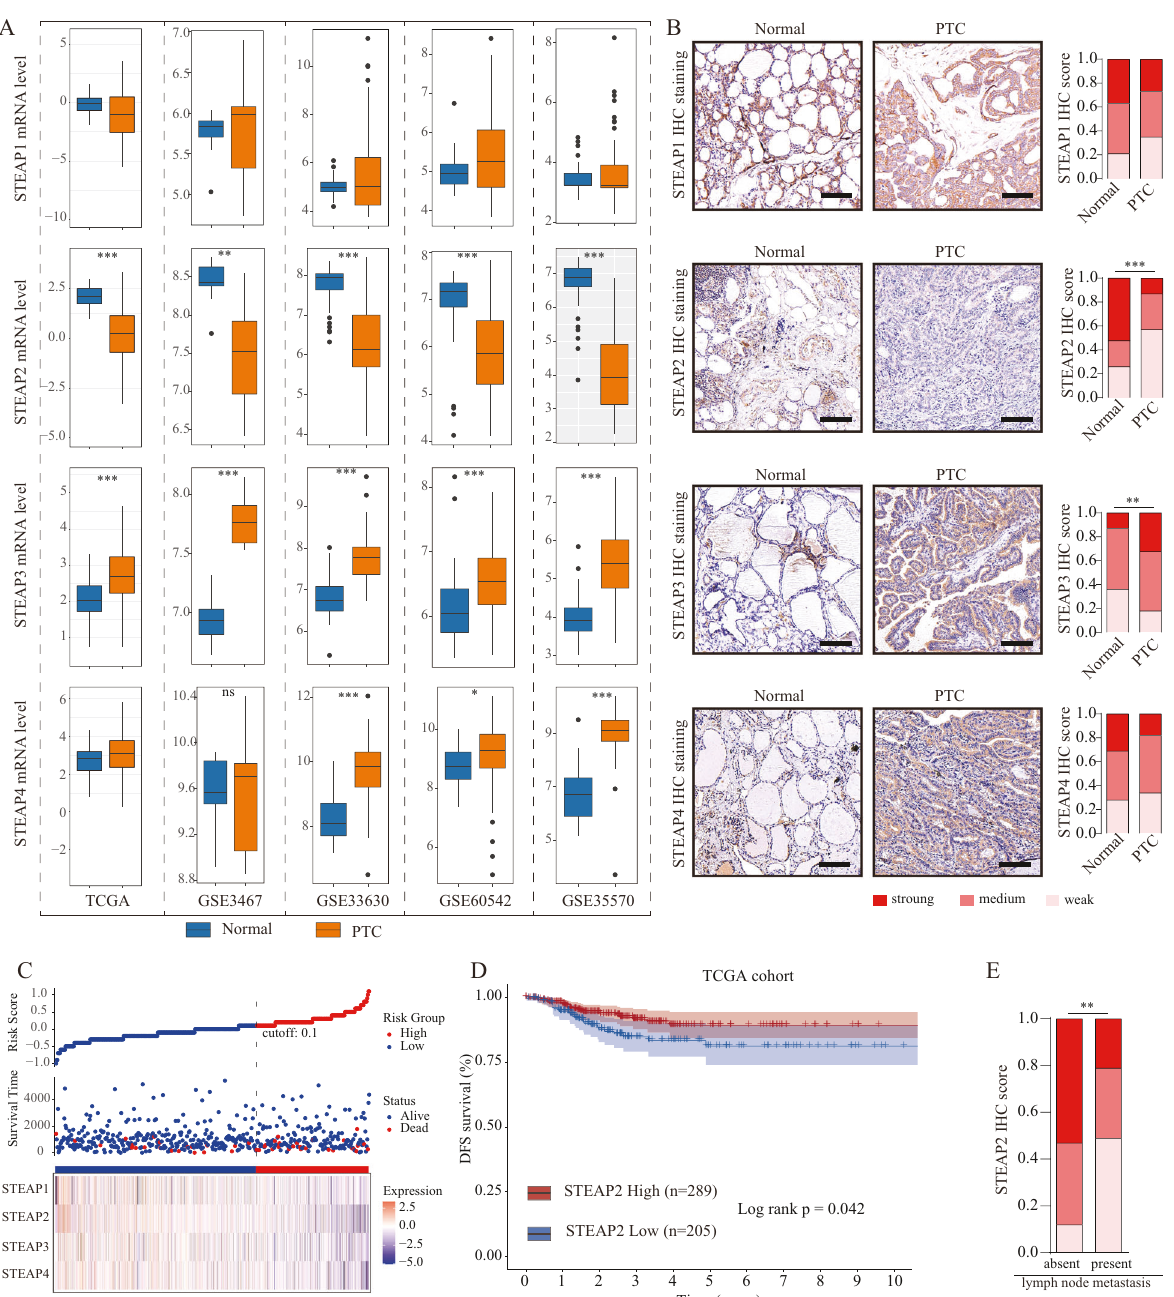
Fig. 1 STEAP2 expression is diminished in PTC tissues. A Identi fi cation of differentially expressed STEAP family members between PTC and normal controls in the TCGA and GEO database (GSE3667, GSE33630, GSE60542, GSE35570). B Panel shows representative fi gures on IHC staining for the 4 STEAP family members (STEAP1/2/3/4) and quantitative data. Scale bar: 200 μ m. C Risk score distribution, survival status scatter plot, and expression patterns of risk genes in the TCGA PTC cohort. D Survival analysis based on STEAP2 expression levels in TCGA PTC cohort ( n = 494). E Distribution of STEAP2 IHC staining scores in PTC tissues according to lymph node metastasis status. * P < 0.05, ** P < 0.01, and *** P < 0.001. METTL3-regulated m6A modi fi cation enhances STEAP2 mRNA decreased mesenchymal molecule marker proteins (N-cadherin, stability in an YTHDF1-dependent manner vimentin, Snail, and β -catenin) and increased epithelial molecule Increasing studies have shown that m6A RNA modi fi cation is an marker (E-cadherin) following STEAP2 reactivation (Fig. 5C). emerging regulatory mechanism for gene expression and plays Furthermore, we detected the expression of the abovementioned vital roles in tumorigenesis [30]. Hence, we explored whether m6A proteins in xenograft tumor tissues via IHC and obtained results modi fi cation was involved in STEAP2 inactivation. Online predic- consistent with the in vitro fi ndings (Fig. 5D, E). Collectively, these tion tool (http://m6a2target.canceromics.org [31]) showed that data indicate that STEAP2 may exert its tumor-suppressive METTL3, a m6A “ writer ” protein, was among the potential m6A function by restraining the Hedgehog signaling pathway and EMT.